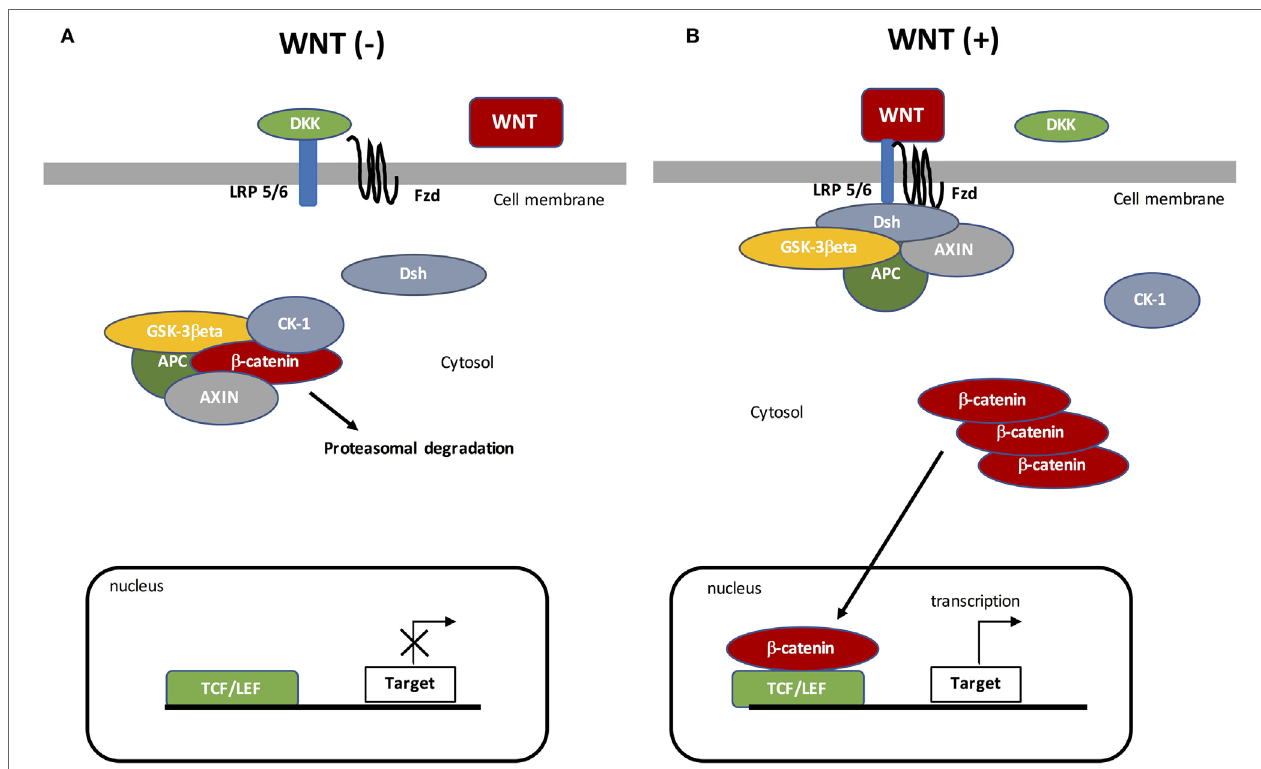
FiGURe 1 | The canonical WNT/ β -catenin pathway. (A) Under resting condition, the cytoplasmic β -catenin is bound to its destruction complex, consisting of adenomatous polyposis coli (APC), AXIN, and glycogen synthase kinase-3 β (GSK-3 β ). After CK-1 phosphorylates on Ser45 residue, β -catenin is further phosphorylated on Thr41, Ser37, and Ser33 residues by GSK-3 β . Then, phosphorylated β -catenin is degraded into the proteasome. Therefore, the cytosolic level of β -catenin is kept low in the absence of WNT ligands. If β -catenin is not present in the nucleus, the TCF/LEF complex cannot activate the target genes. DKK can inhibit the WNT/ β -catenin pathway by binding to WNT ligands or LRP5/6. (B) When WNT ligands bind to both frizzled (FZD) and low-density lipoprotein receptor- related protein 5 (LRP5/6), Disheveled (DSH) is recruited and phosphorylated by FZD. Phosphorylated DSH in turn recruits AXIN, which dissociates the β -catenin destruction complex. Therefore, β -catenin escapes from phosphorylation and subsequently accumulates in the cytosol. The accumulated cytosolic β -catenin goes into the nucleus, where it binds to T-cell factor/lymphoid enhancer factor (TCF/LEF) and activates the transcription of target